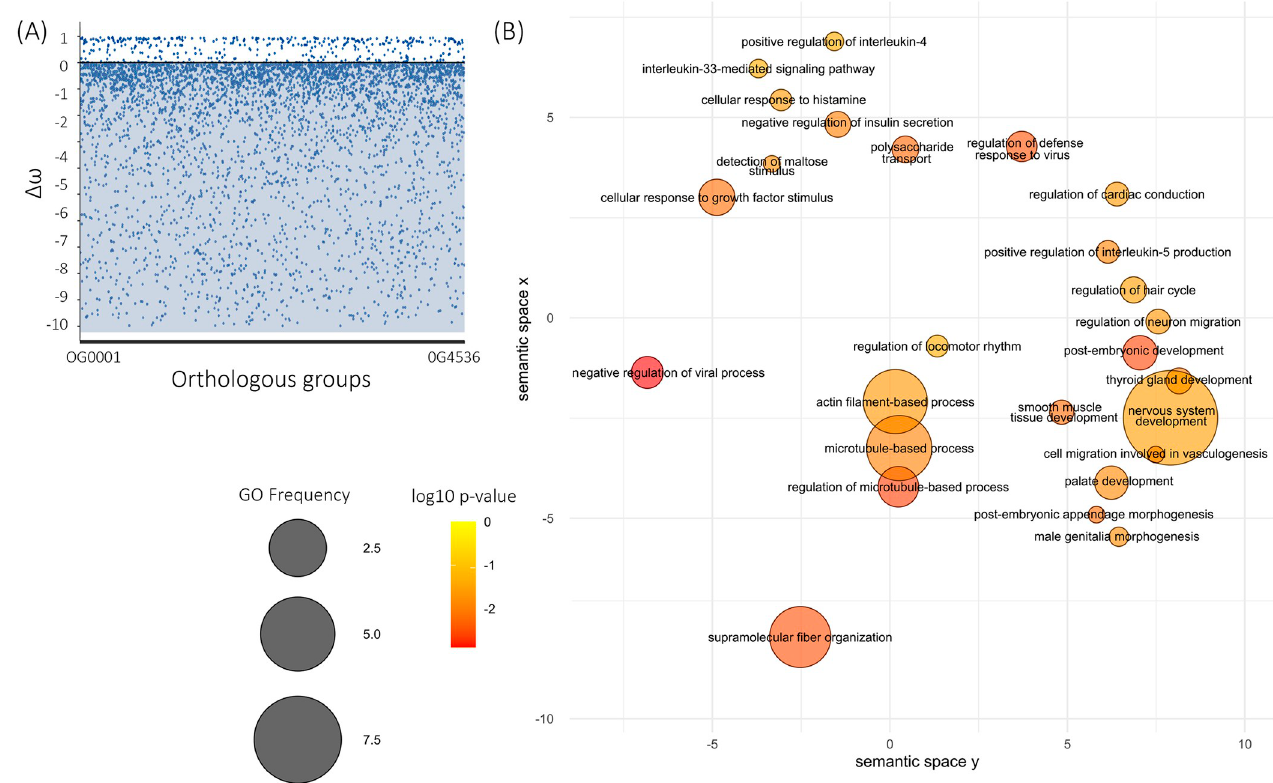
Fig 2. Results of selection test for neutral model (M1) vs. selection model (M2) per OGs and enrichment gene ontology for clusters under positive selection. (a) Δ ω value per OG, where negative values indicate potential positive selection. Each dot represents one single gene cluster and respective Δ ω on the y-axis. (b) Enrichment Gene Ontology (GO) result from OGs under positive selection for Nelore. Each circle represents an over-represented GO term: the colors indicate the log10 of the p-value; the size reflects the frequency of the GO.